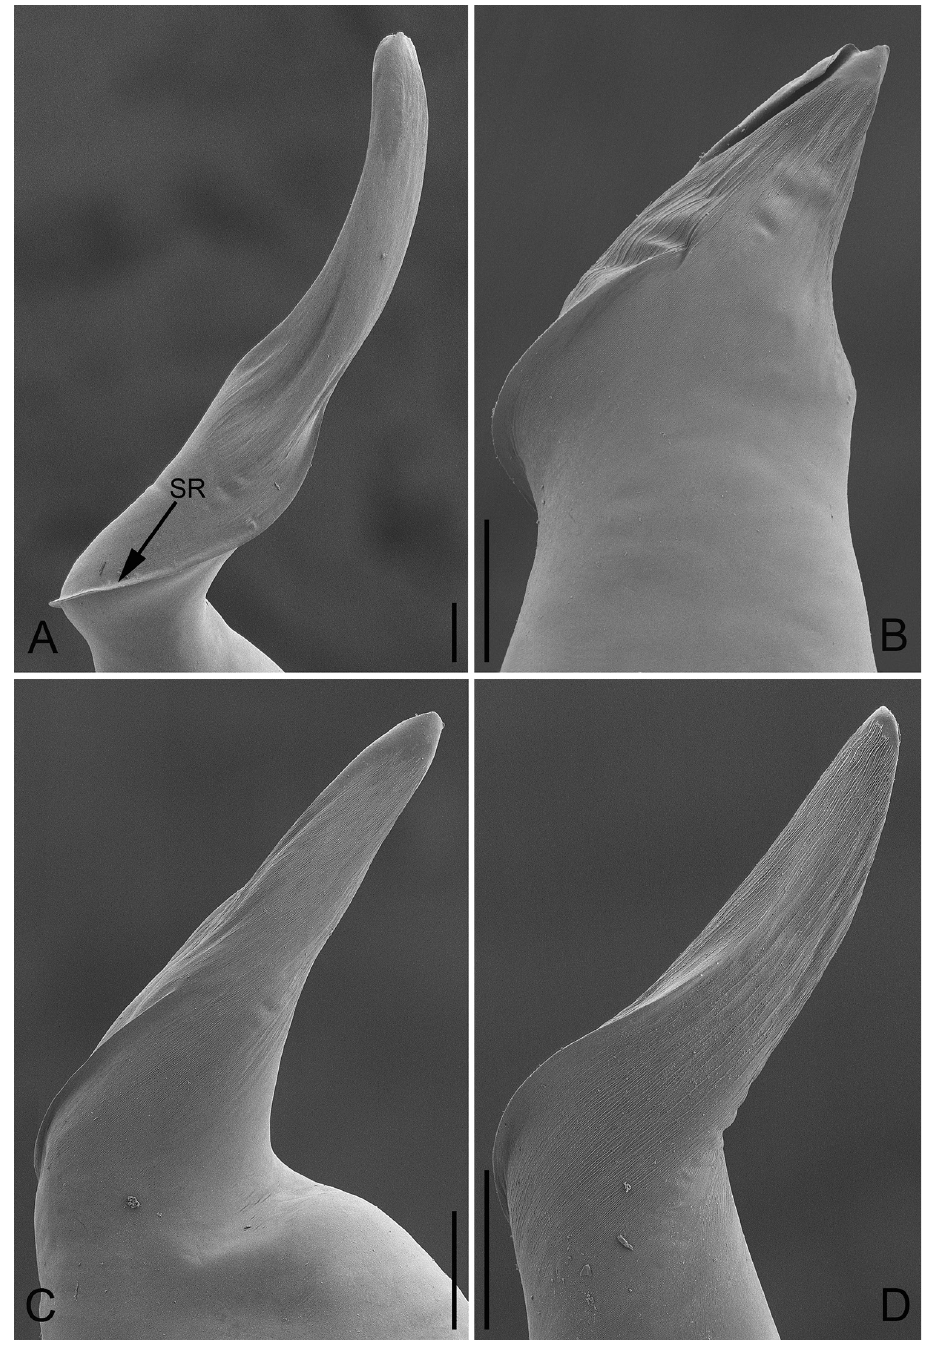
Figure 9. Prolateral view of embolus of P. bailongensis ( A ); P. cunfengensis sp. n. ( B ); P. podiensis sp. n. ( C ); P. qingfengensis sp. n. ( D ). Scale bars: 0.05